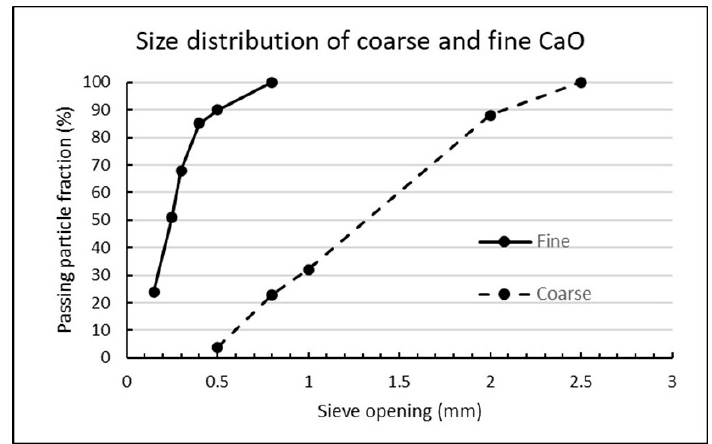
Figure 6. Sieving curves for fine and coarse CaO (burnt lime).